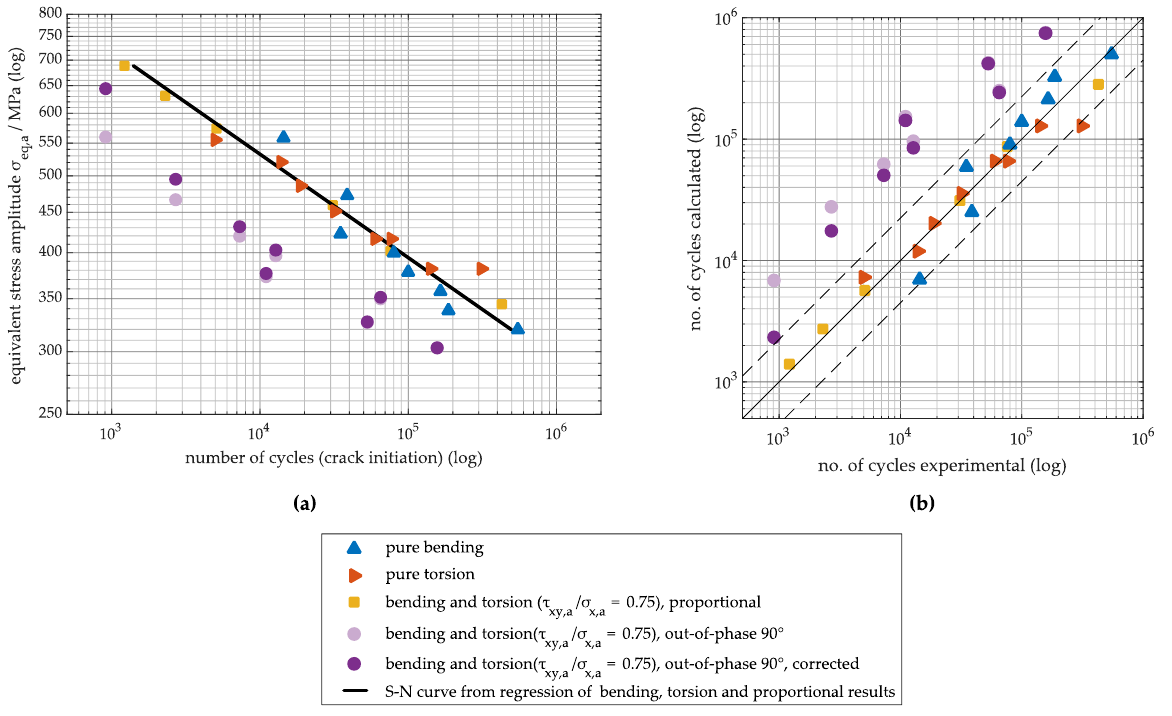
Figure 17. Test results from Figure 12 evaluated with scaled normal stresses and results for nonproportional loading corrected with factor for nonproportional hardening n np : ( a ) equivalent stress amplitudes according to scaled normal stresses and ( b ) number of cycles calculated based on the proportional S – N curve over an experimentally determined number of cycles.